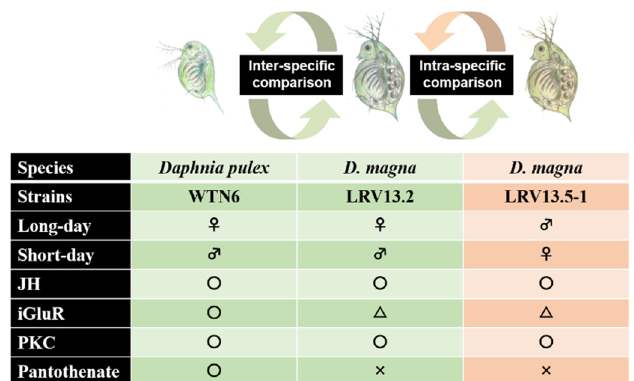
Figure 4. Comparative schematic diagram of putative molecular signaling cascades regulating male offspring production in D. pulex WTN6 strain (left), in D. magna LRV13.2 strain (center), and in D. manga LRV13.5-1 strain (right). Long-day: 14 h-light and 10 h-dark, short-day: 10 h-light and 14 h-dark, JH: juvenile hormone, iGluR: ionotropic glutamate receptor, PKC: protein kinase C. Each symbol (circle, triangle, and cross) mean the “male-inducible”, “non male-inducible”, “treatment of antagonists can suppress male induction, but that of agonists cannot”.